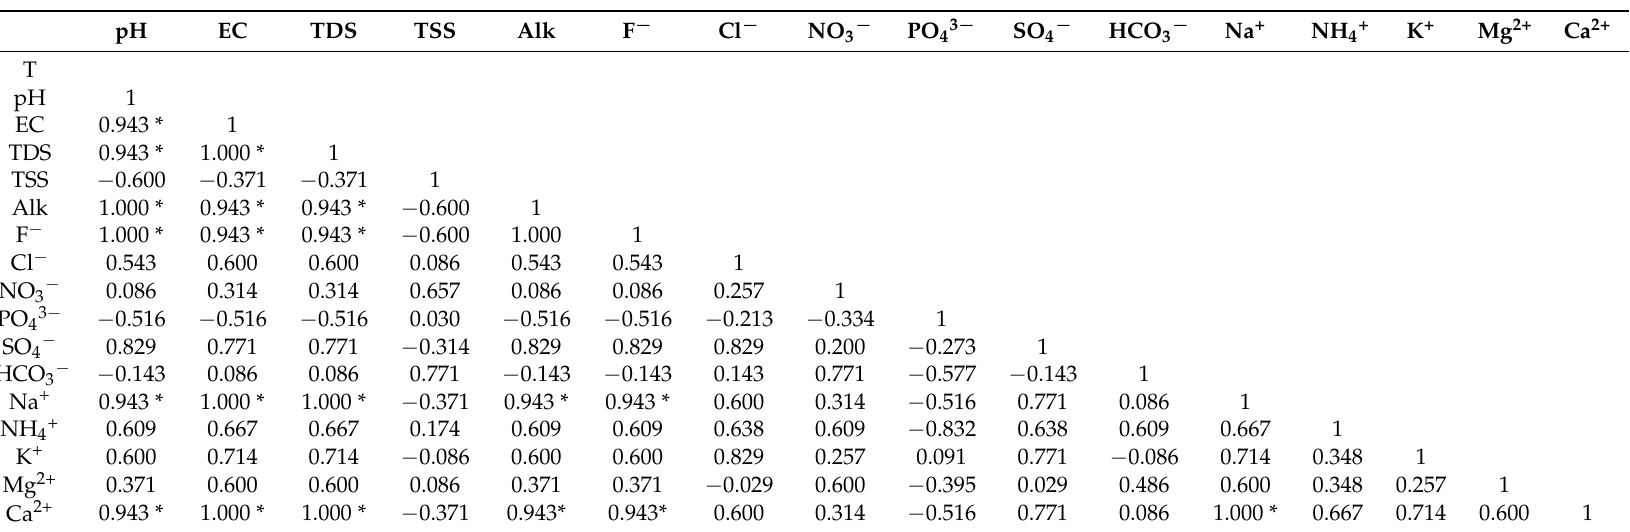
Table 5. Pearson’s correlation coefficients for physicochemical parameters of water